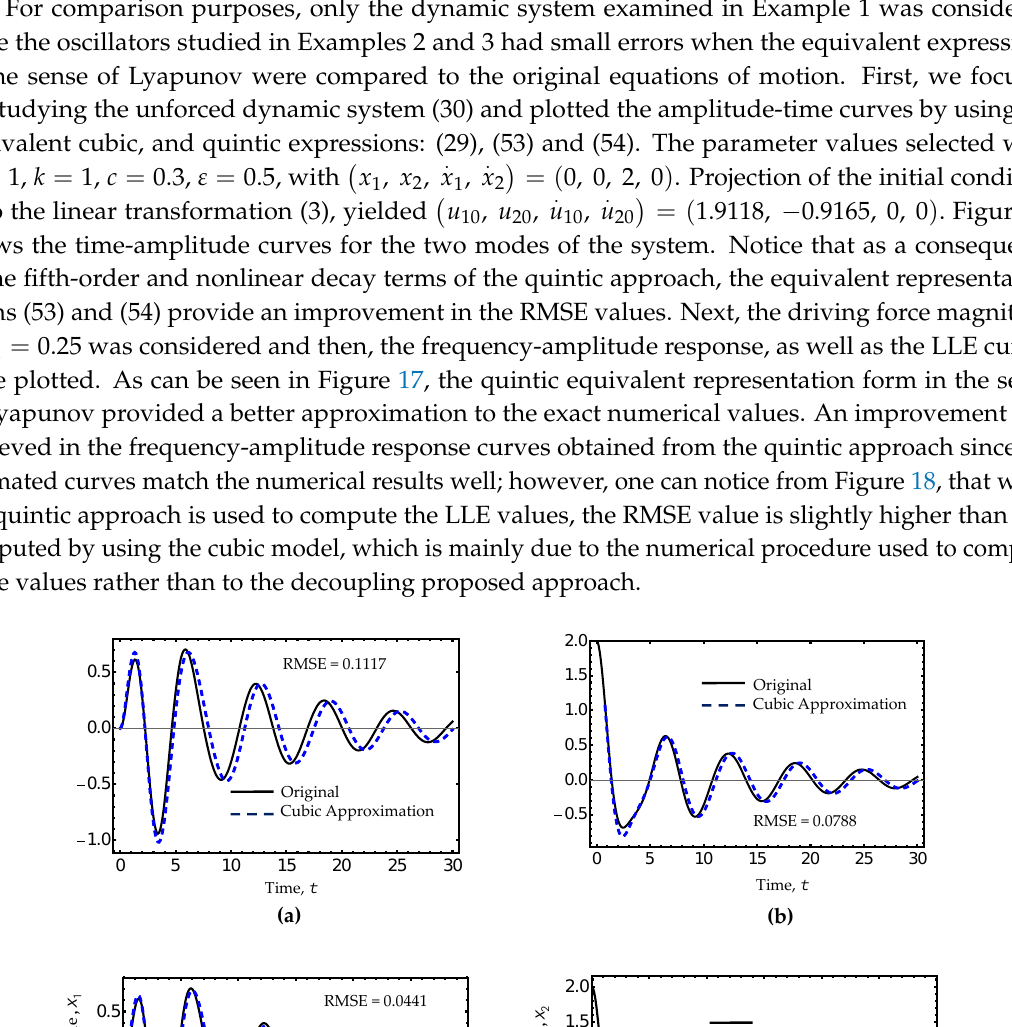
Figure 17. Frequency-amplitude response curves computed from the numerical integration solutions of Equations (53) and (54). Cubic approximation: ( a ) x 1 vs  f , (b) x 2 vs  f . Quintic approximation: (c) x 1